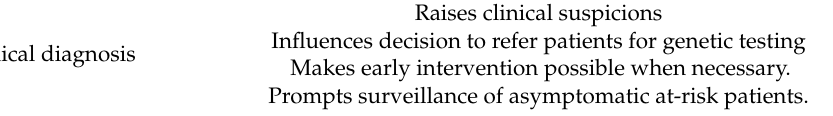
Table 1. Ways in which awareness of nonmalignant features of CRC predisposition syndromes are important for